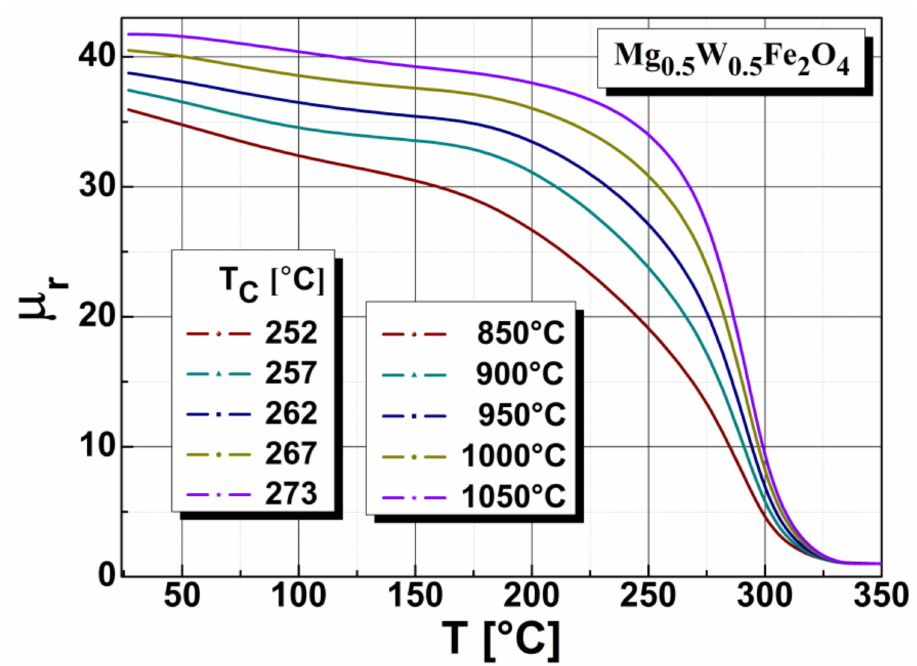
Figure 6. The influence of annealing temperature on the Curie temperature characteristics of Mg 0.5 W 0.5 Fe 2 O 4